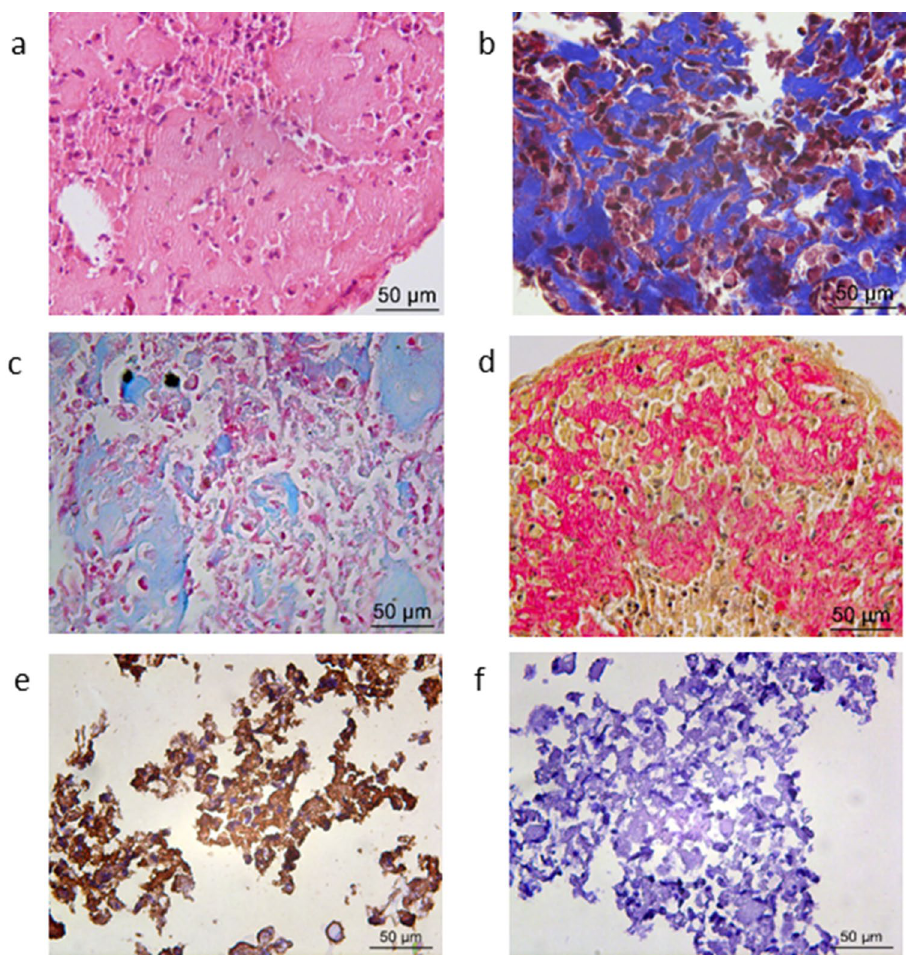
Figure 2. Micromass results stimulated with IGF-1 for 21 days by chondrogenic differentiation: Histological analysis (400 ×): H&E stain (neoformed matrix appears in pink) ( a ), Masson’s trichrome (collagens appear in blue) ( b ), Alcian Blue stain (glycosaminoglycans appear in light blue) ( c ), and Picrosirius Red stain (collagens fibers appears in red) ( d ); positive immunohistochemical staining for specific Type II collagen ( e ) and negative control ( f